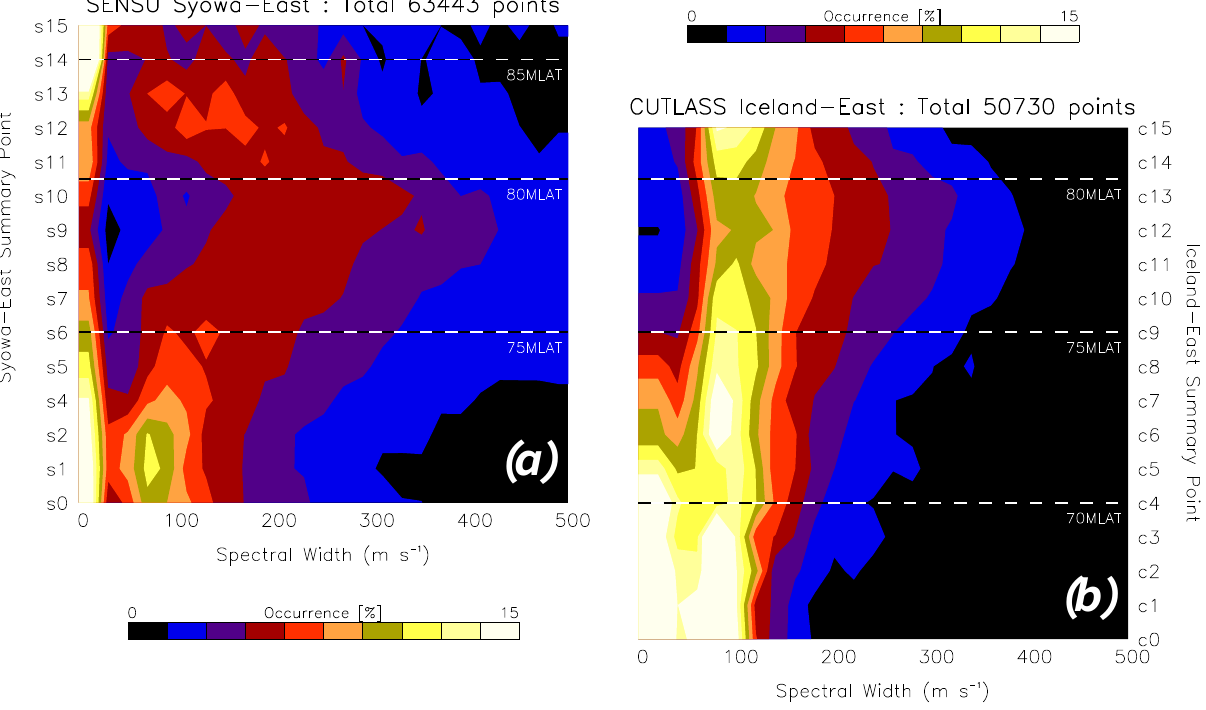
Fig. 4. The occurrence distribution of spectral widths observed by (a) SENSU Syowa-East radar and (b) CUTLASS Iceland-East radar. The vertical axis indicates the summary points from S0 to S15 for Syowa-East and C0 to C15 for Iceland-East, and the horizontal axis is the spectral